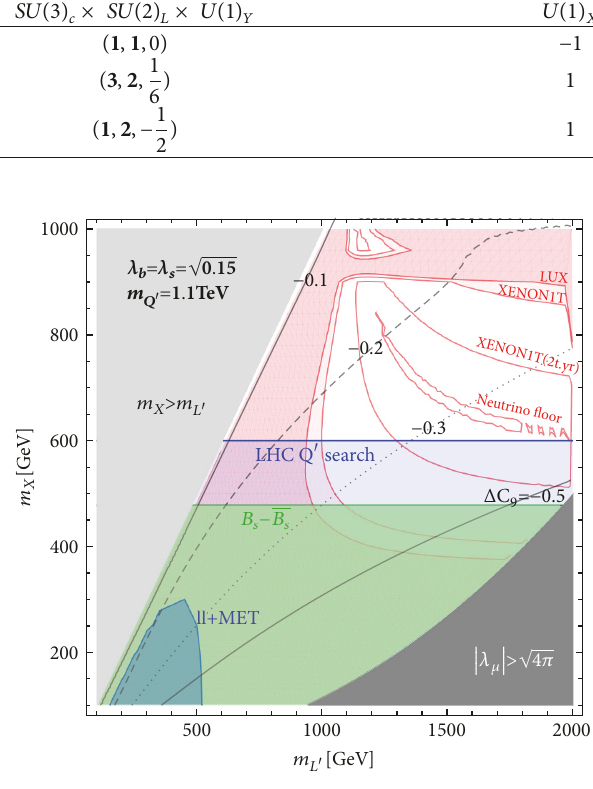
휇, NP 𝑚 − 𝑚 Figure 6: Contours of constant 𝐶 퐿 푋 plane for 9 in the the model of [13]. This figure has been obtained with fixed 𝜆 푏 푄 = 𝜆 푠 = √0.15 and 𝑚 = 1.1 TeV, choosing 𝜆 휇 푄 퐿 in order to reproduce 푄 the observed DM relic density. The colored regions are excluded by various constraints: heavy quark and lepton searches at the LHC (blue), 𝐵 푠 −𝐵 푠 mixing (green), and direct DM detection experiments (red).Thegreyregionsareexcludedduetoperturbativityconstraints 휇 𝜆 Figure 5: Required values for 𝜆 휇 in this figure) and 퐿 (denoted as (dark grey region) or by demanding that 𝑋 is the lightest 𝑈(1) 푋 - 𝑚 𝑅 𝑅 푋 to explain the observed values of 퐾 and 퐾 ∗ in the model of charged state (light grey region). Future direct DM detection [13]. This figure has been obtained with fixed |𝜆 푏 푄 𝜆 푠 푄 | = 0.15 , 𝑚 퐿 = 1 prospects are also shown in this plot. Figure taken from TeV, and 𝑚 푄 = 1.1 TeV. The light (dark) red region corresponds to the 𝑅 퐾 measurement at 1𝜎 ( 2𝜎 ), whereas the red lines indicate the same regions for 𝑅 퐾 ∗ . The green region is excluded due to 𝐵 푠 − 𝐵 푠 mixing for 𝑚 푄 = 1.1 TeV. The excluded region would extend up to the dashed green line for 𝑚 푄 = 1 TeV. Figure taken from [13].